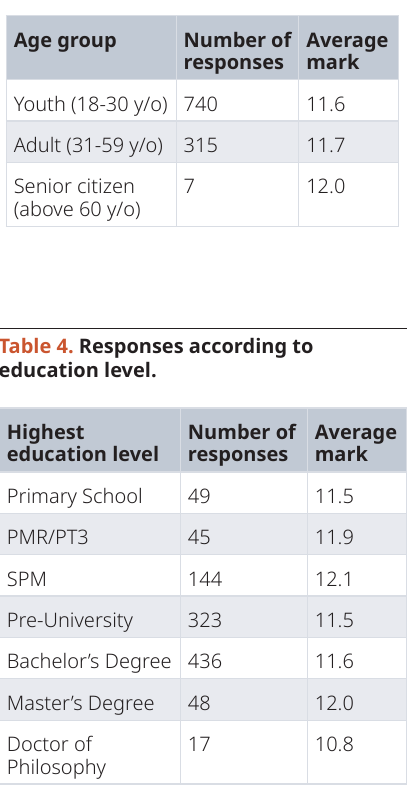
Table 3. Responses according to age.